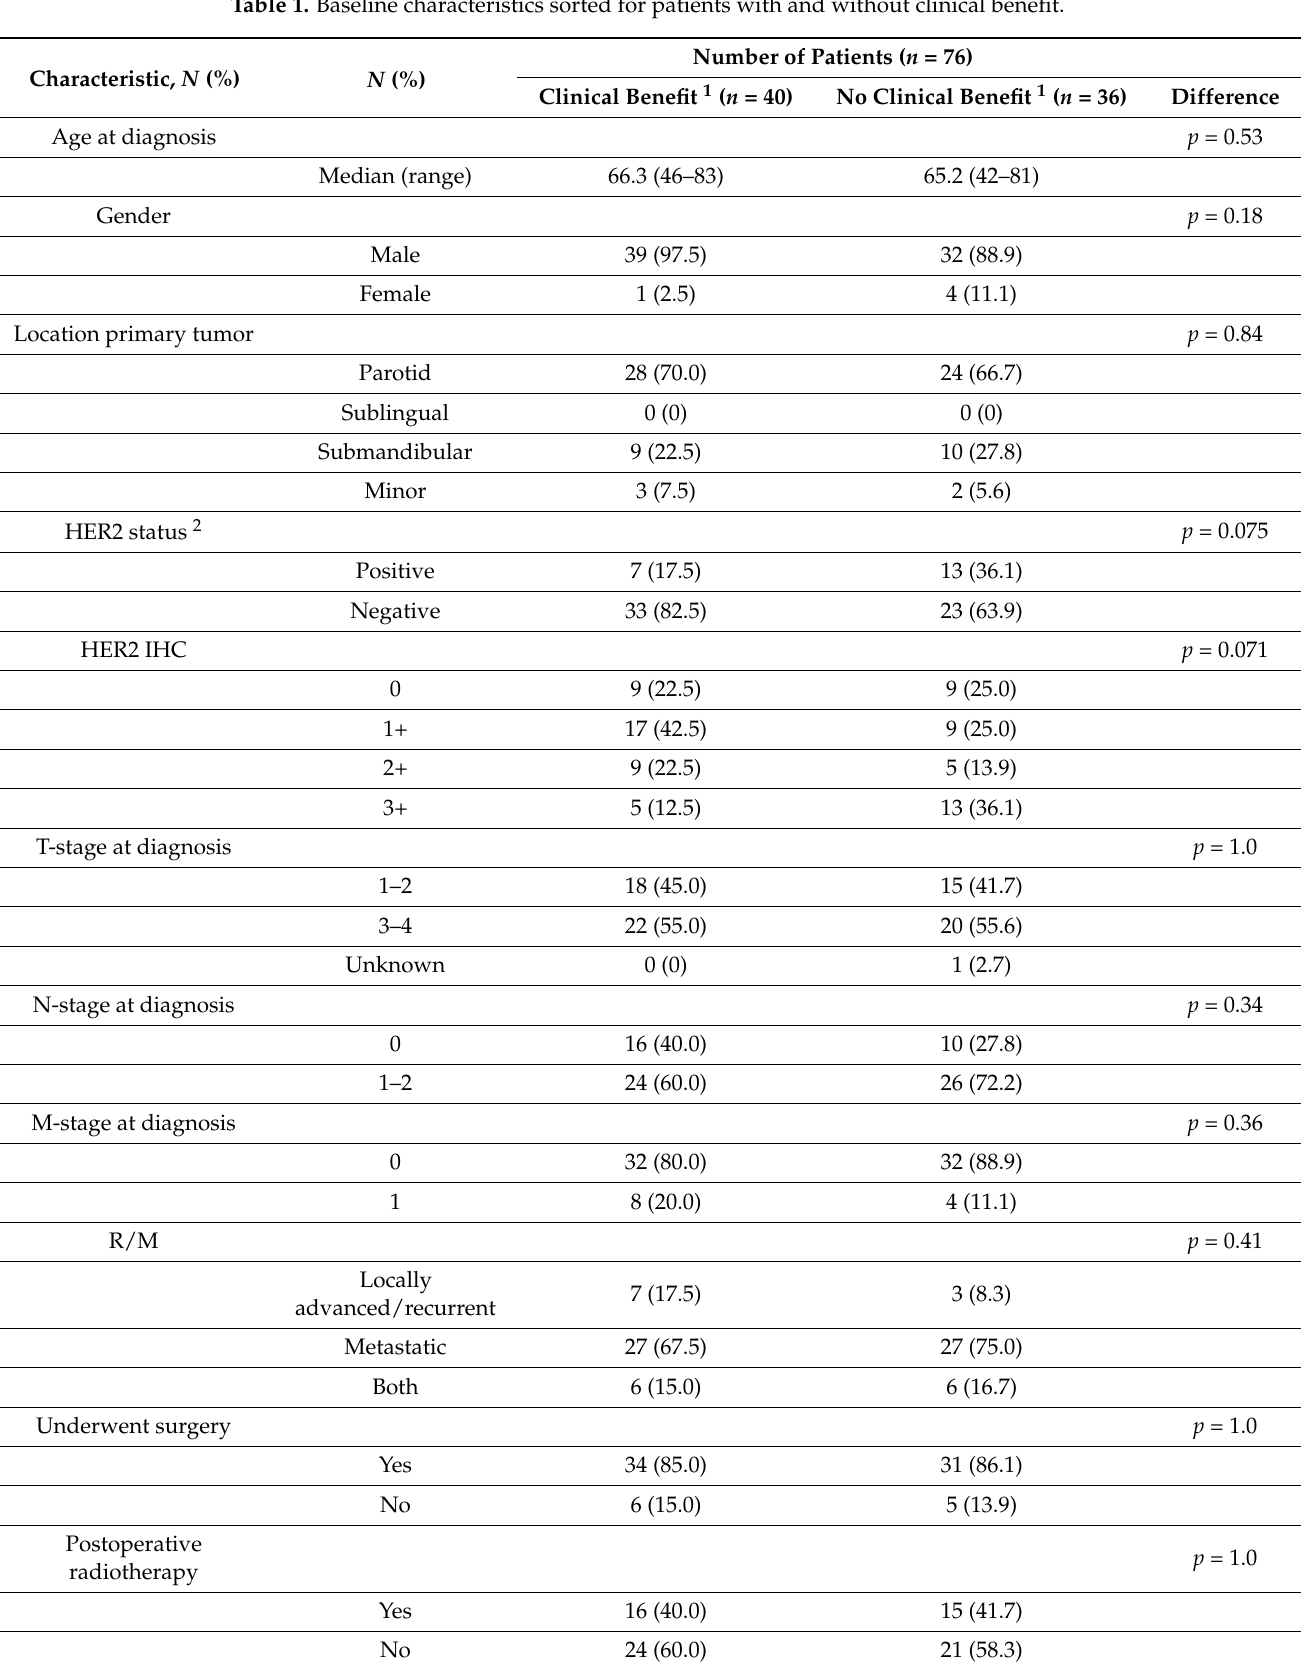
Table 1. Baseline characteristics sorted for patients with and without clinical